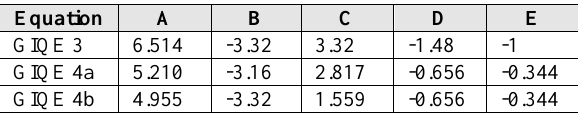
Table 1. GIQE 3 and 4 coefficients for GSD in metric units